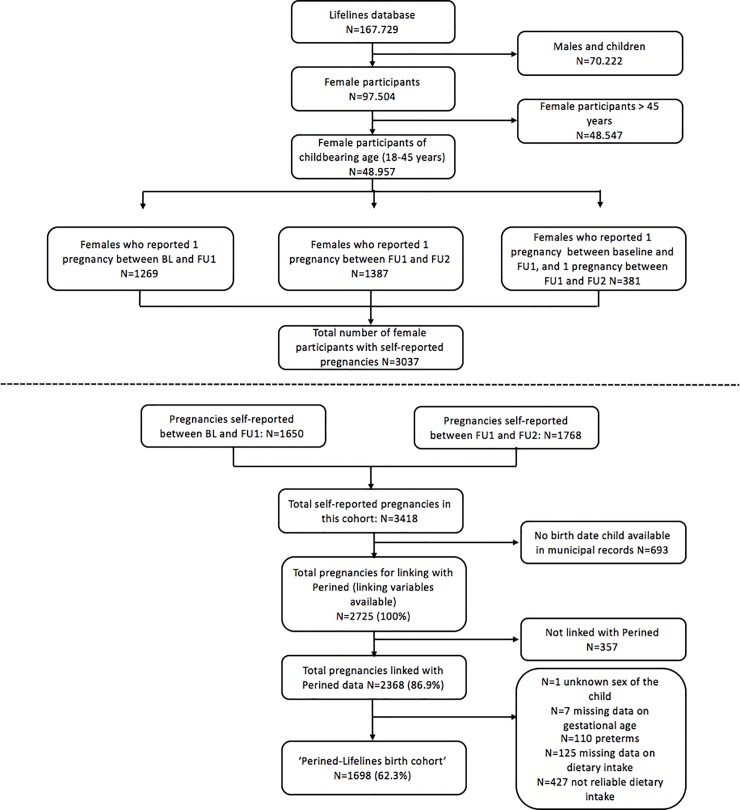
Flow chart of the Perined-Lifelines linked birth cohort.